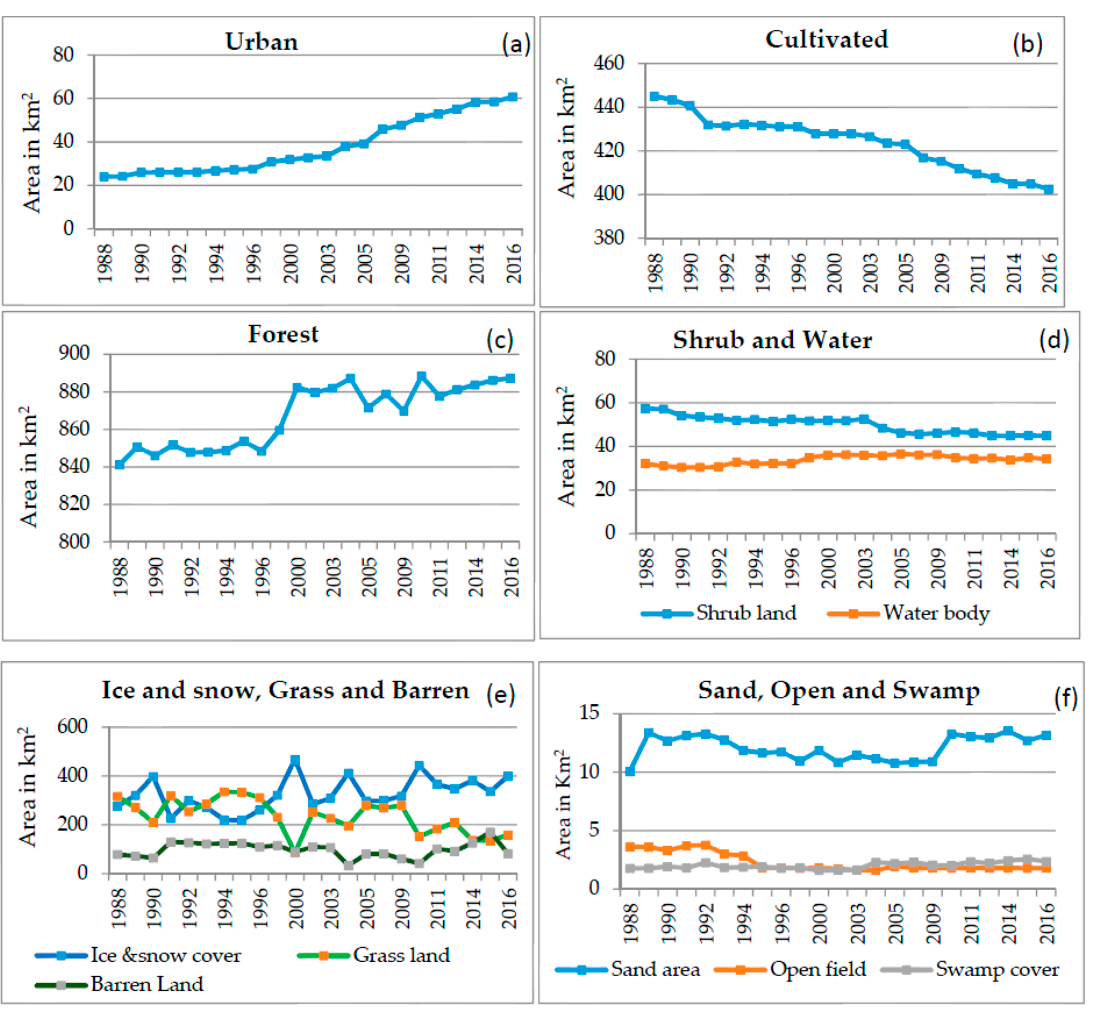
Figure 4. LULC trend during 1988–2016 for land-use types ( a ) urban/built-up; ( b ) cultivated; ( c ) forest; ( d ) shrub and water; ( e ) ice and snow-cover, grass land and barren land ( f ) sand, open and swamp-cover.